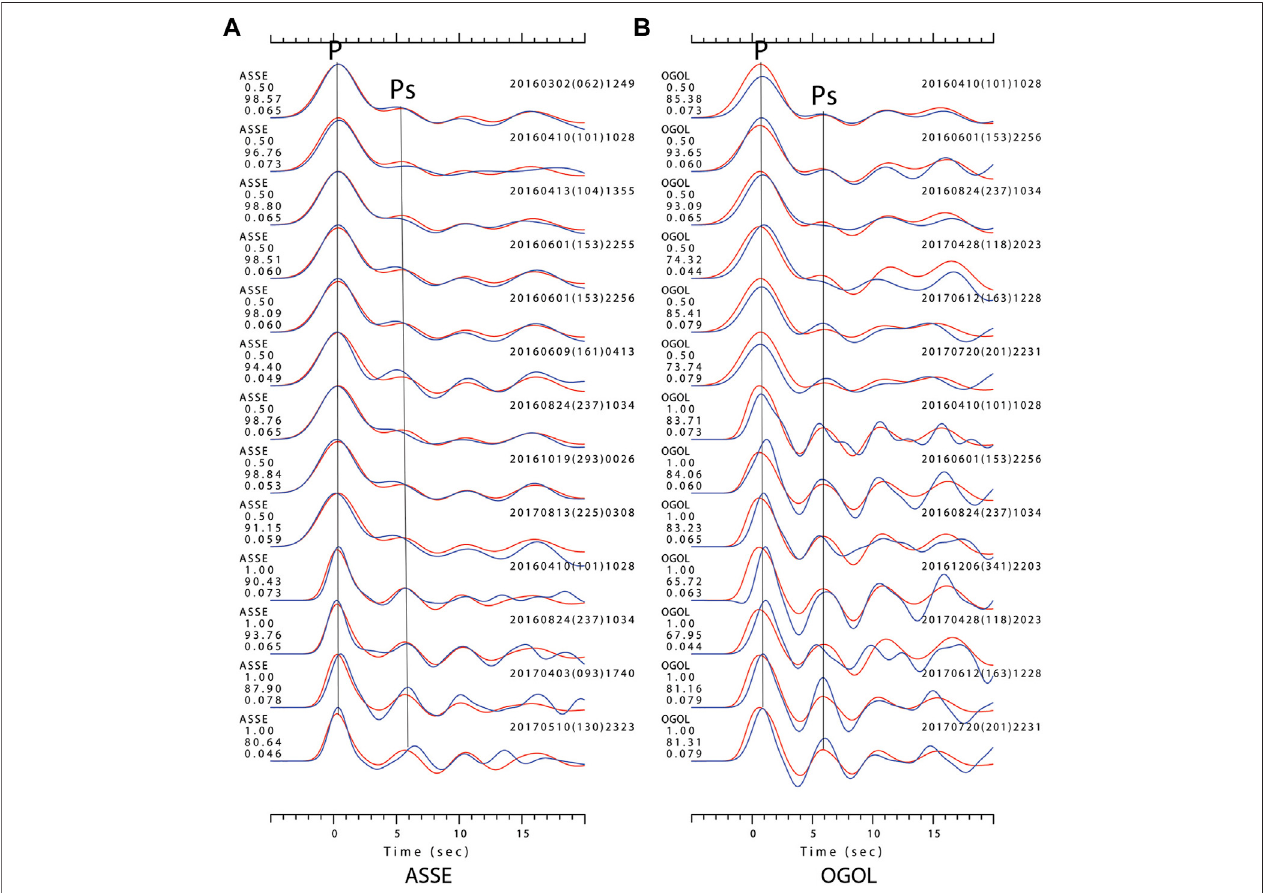
FIGURE5|(A) and (B) areRFsofASSEandOGOLstations.TheASSEstationlocatedontheeasternplateau,whichisthebest fi tRFofthisstudy,whereasstation OGOL is located in the central MER (CMER) rift margin near the eastern plateau, which has the largest mis fi t of all the RFs. Blue-coloured RFs in the background are synthetic, whereas the red-coloured RFs on top are the observed RFs. P represents the direct primary wave, and Ps is the converted phase at the Moho. The numbers ontheleftshowthestationname,Gaussianwidthparameter, percentage of fi t,and theapplied rayparametersforthespeci fi edRF. Thenumberstotherightofthe RFs are the occurrence time of the earthquakes. In (A) , two signals and in (B) six signals are calculated twice for the Gaussian width parameters of 0.5 and 1.0.